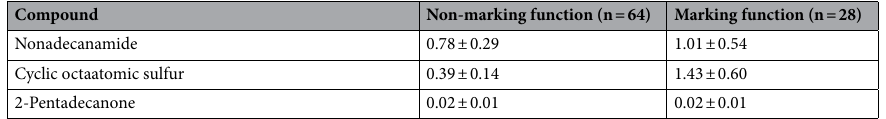
Table 4. Relative proportions (mean ± SE) of compounds in feces of Iberian wolves ( Canis lupus signatus ) depending on the presumably marking function of these feces in intraspecific